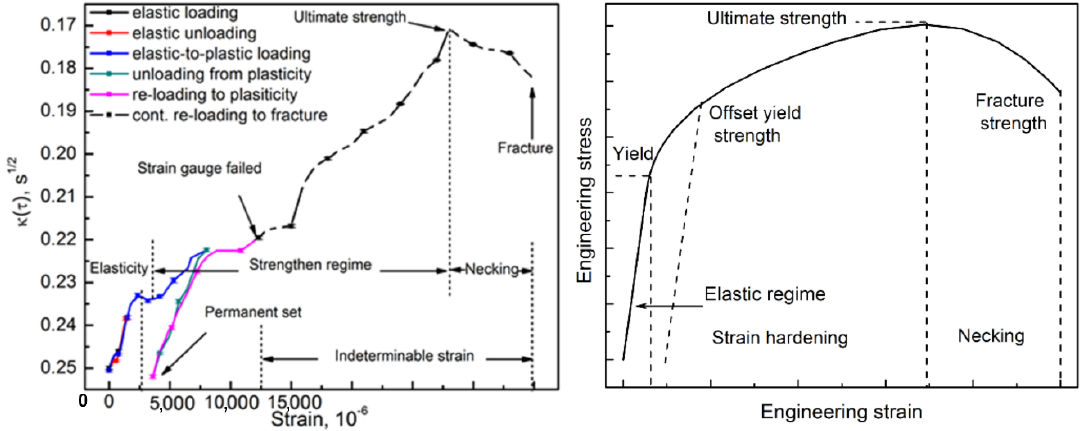
Figure 9. Composite thermal parameter κ as a function of strain that shows good analogy with a typical engineering stress-strain curve, reproduced from [100] with permission from Elsevier © 2016. Photothermal techniques have advantages over other methods in characterizing stress-strain relations. Compared with PA, PTMR detection usually evaluates mechanical performance through diffusivity changes. Coupling between thermoelastic properties can be completely separated and the mechanical stress-strain relation can be represented by a single parameter. In addition, dynamic PT techniques generate thermal-wave fields inside a sample where the effective thermal diffusion length can be controlled by the modulation frequency or the delay time of the photothermal source which can be made to impinge on specific locations and thus can be more sensitive to regionally distributed stresses. The use of continuous wave lasers and thermal infrared detectors and cameras